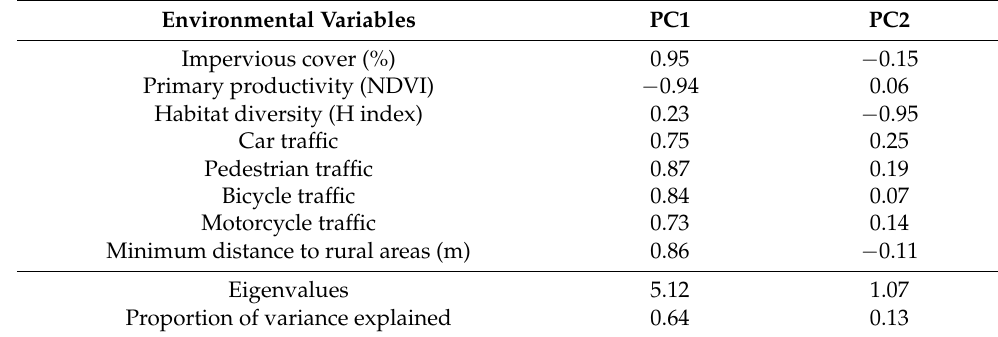
Table 1. Results of the principal component analysis (PCA) between species and their median values of the environmental variables. Numbers are loadings between each environmental variable and the first and second principal components (PC1 and PC2,